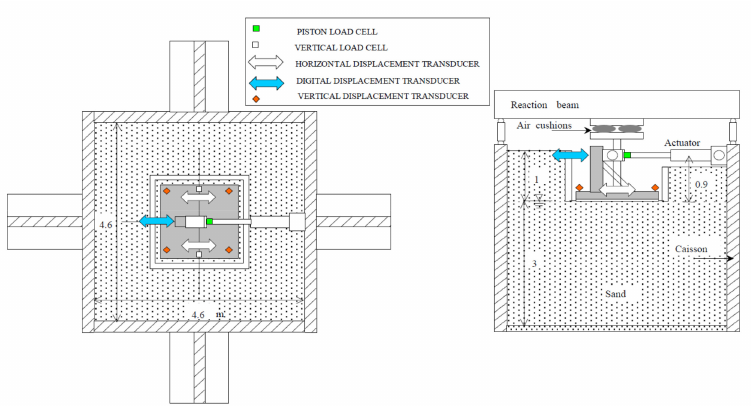
Figure 1. Experimental setup (m) [12].